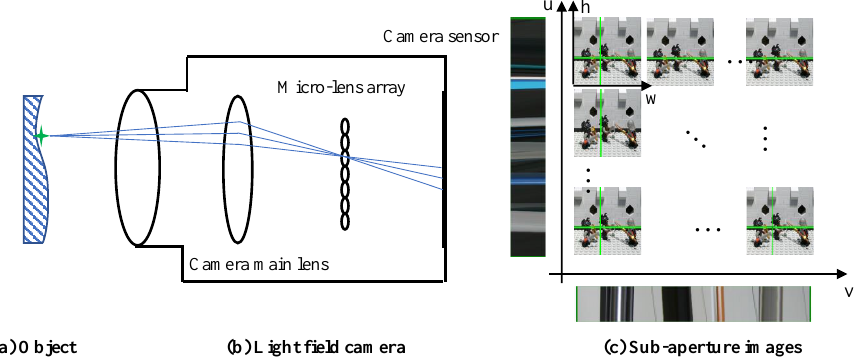
Figure 1. Principle of LF camera. ( a ) Information of the object. ( b ) Light rays captured by the light field camera. ( c ) Sub-aperture images contain the spatial and angular information of the object, and the epipolar images are extracted along the green